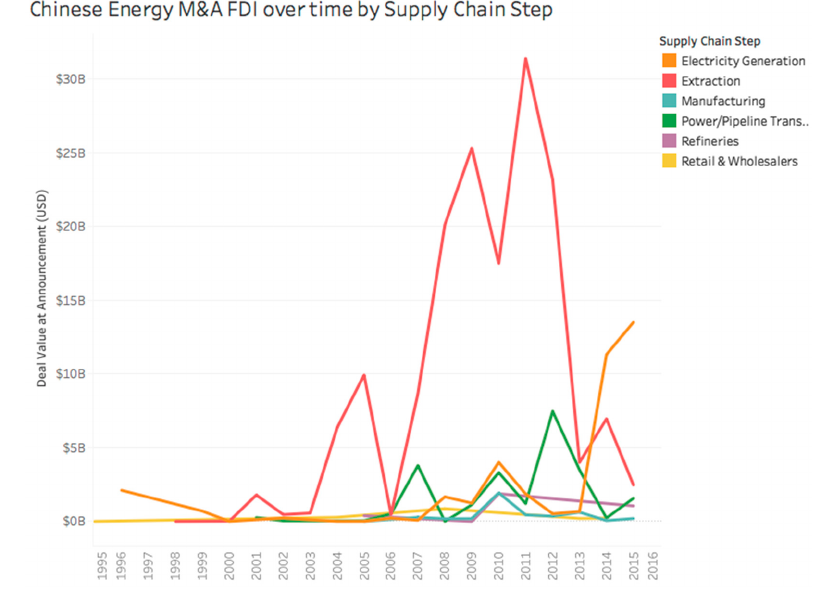
Figure 13. Growth of China’s outbound energy M&A investment by supply chain segments.